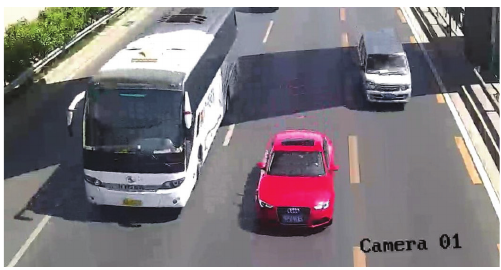
Figure 2. Actual radar